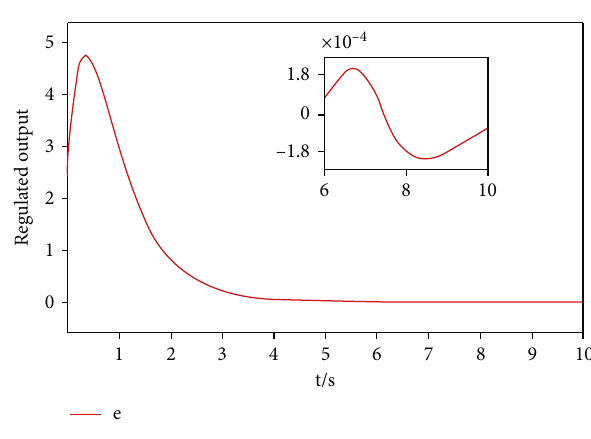
Figure 4: States responses.